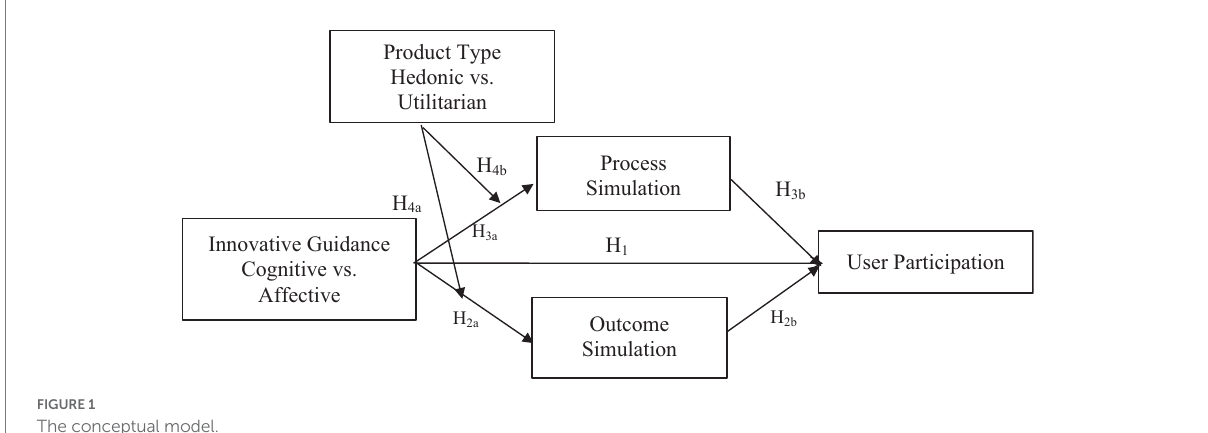
FIGURE 1 The conceptual